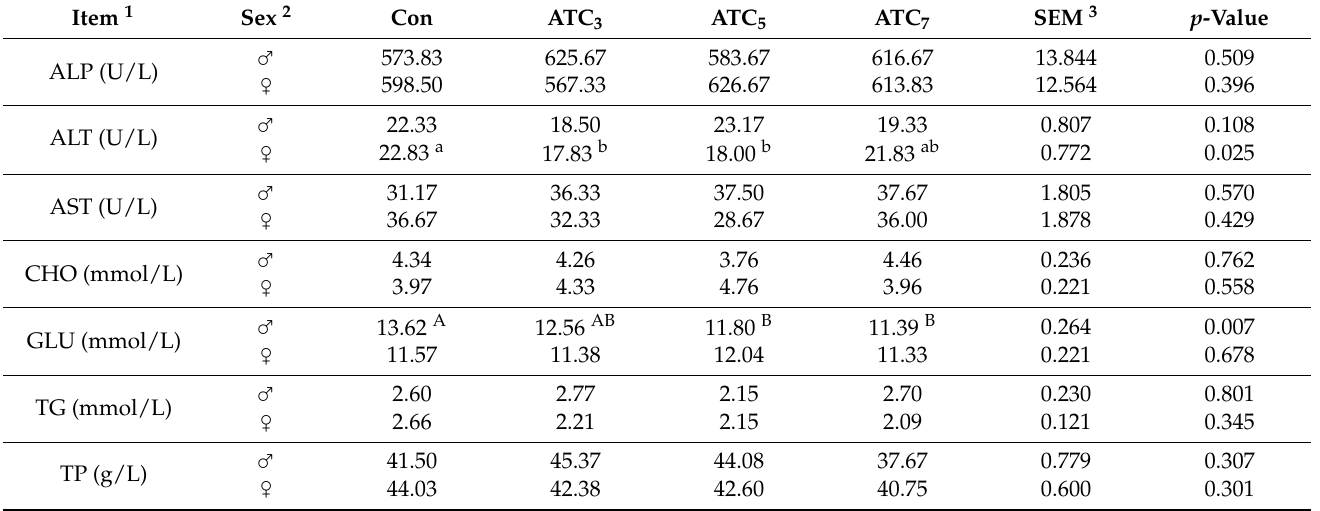
Table 5. The effects of ATC on the biochemical indexes of goose serum ( n =